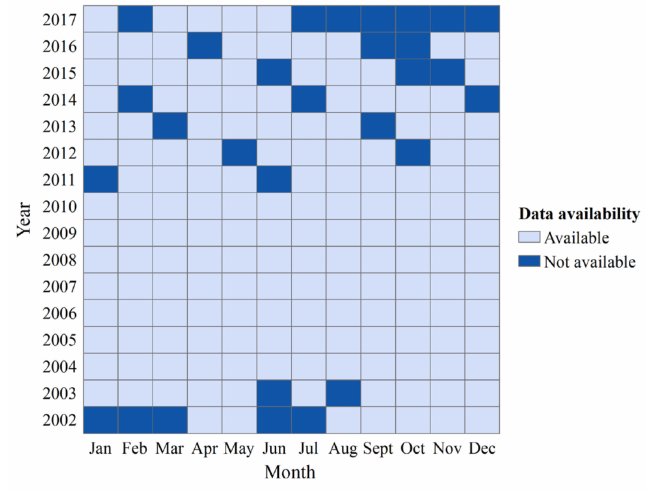
Figure 2. Time distribution and availability of the GRACE data. Table 1. GLDAS variables used in this